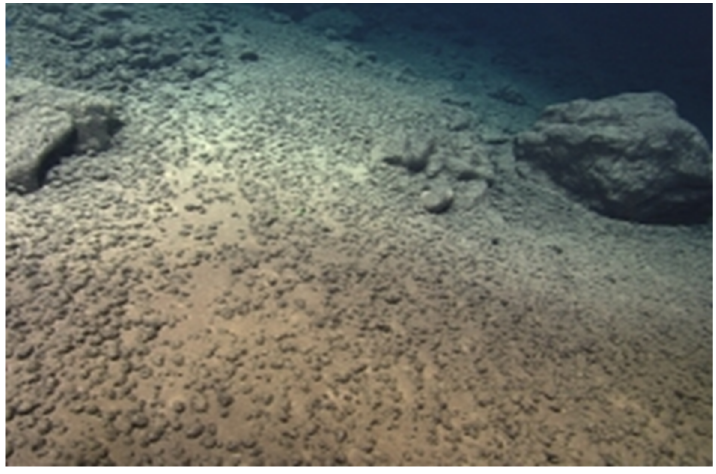
Figure 1. Polymetallic nodules (Source: ISA).